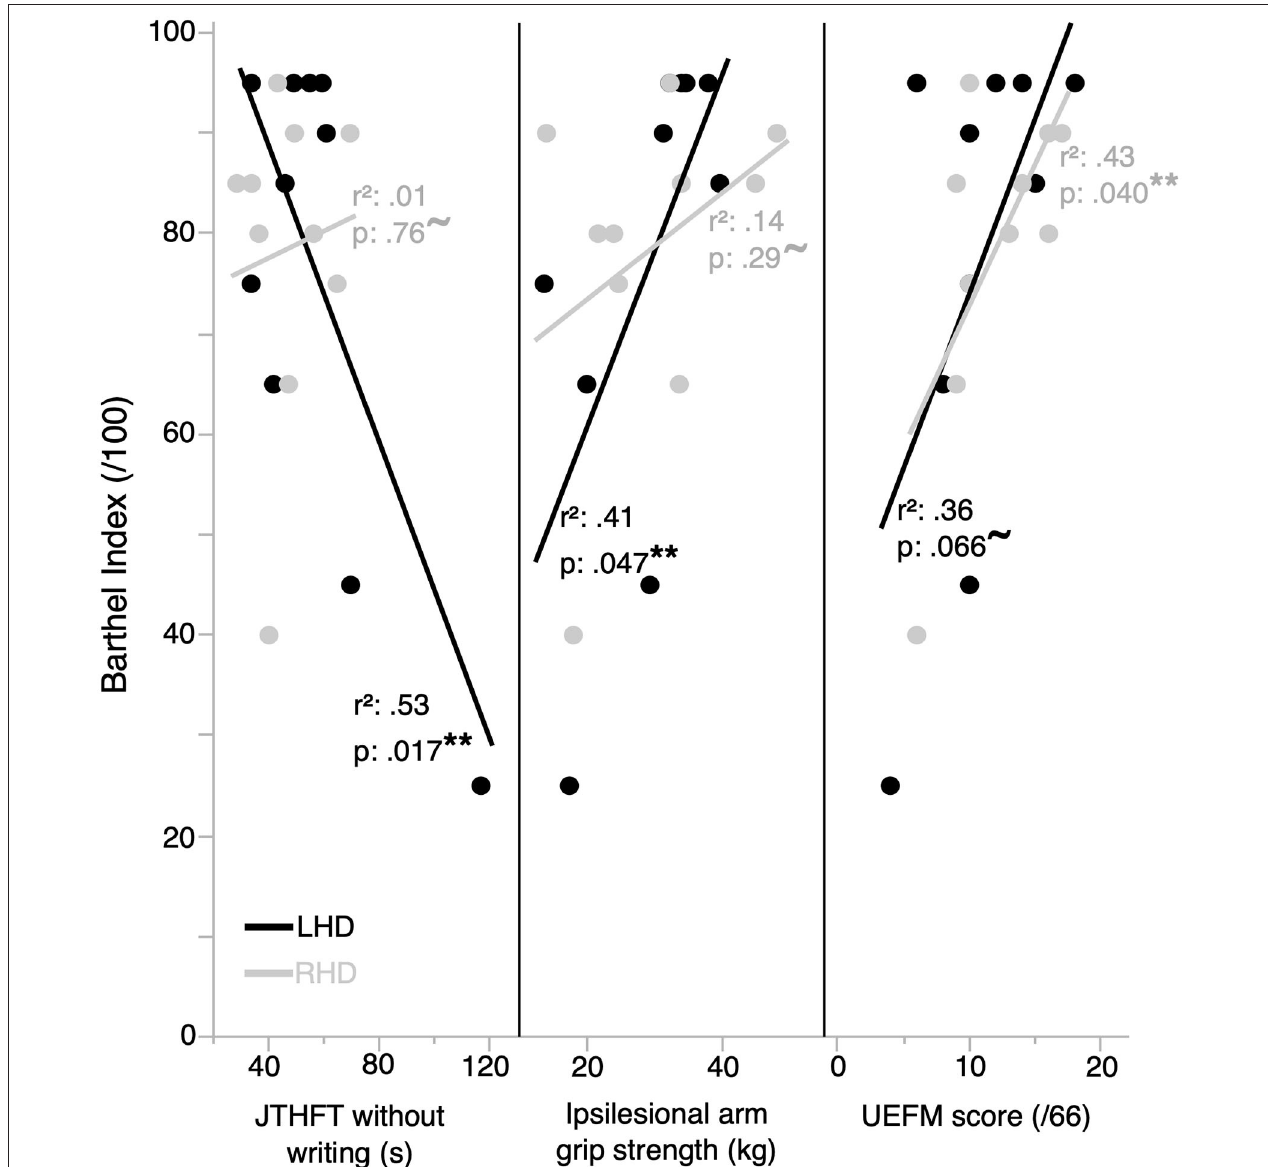
FIGURE 2 | Functional independence is correlated with clinical measures of performance in the ipsilesional and contralesional arms. Functional independence is better correlated with ipsilesional arm clinical measures of performance in the LHD group ( n = 10), and by contralesional arm impairment in the RHD group ( n = 10). **represents statistically significant correlations; ∼ represents correlations that are not statistically significant.